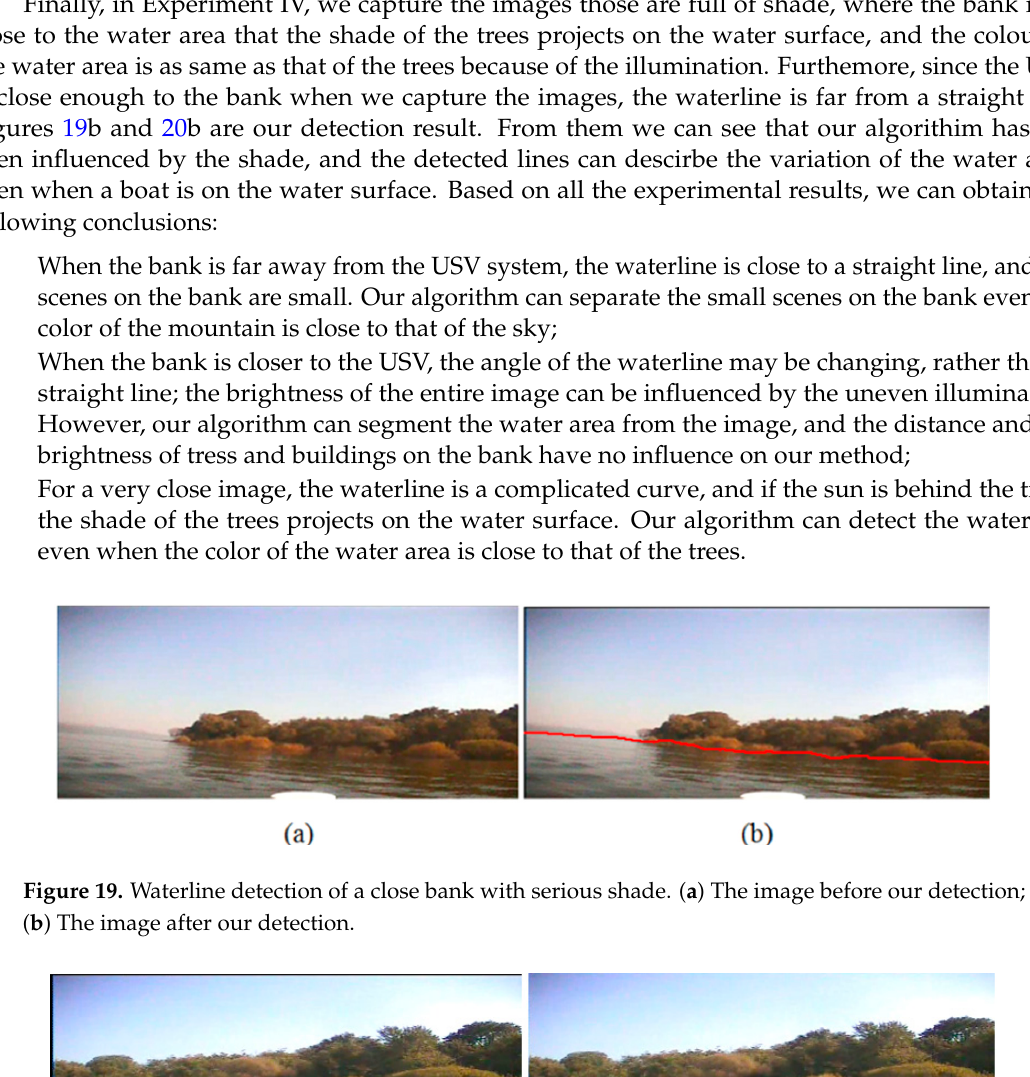
Figure 18. Waterline detection of a closer bank with uneven illumination. ( a ) The image before our detection; ( b ) The image after our detection.